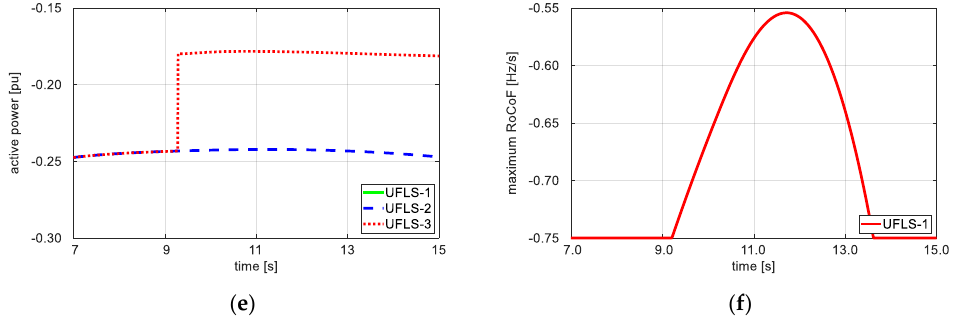
Figure 8. Time variation of selected variables during the unloading process—Case D: ( a ) frequency, ( b ) membership functions and UFLS output y , ( c ) frequency derivative (RoCoF), ( d ) corrected minimum frequency f * min , ( e ) active power disconnected, ( f ) maximum RoCoF f (cid:48)∗ max .